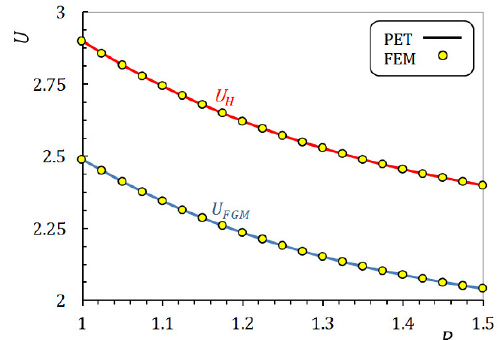
Figure 3. Radial distribution of radial displacement